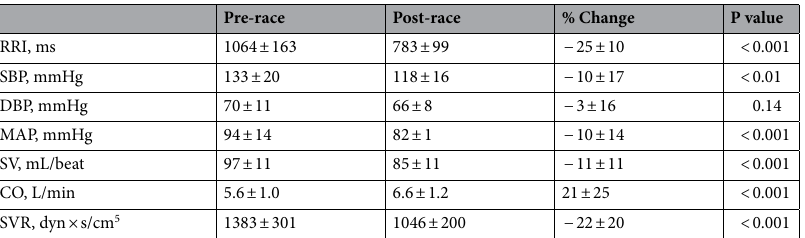
Table 2. Pre- and post-race values of haemodynamic parameters in the examined men (N = 23). Data are presented as mean ± SD; RRI, RR interval; SBP, systolic blood pressure; DBP, diastolic blood pressure; MAP, mean arterial blood pressure; SV, stroke volume; CO, cardiac output; SVR, systemic vascular resistance.